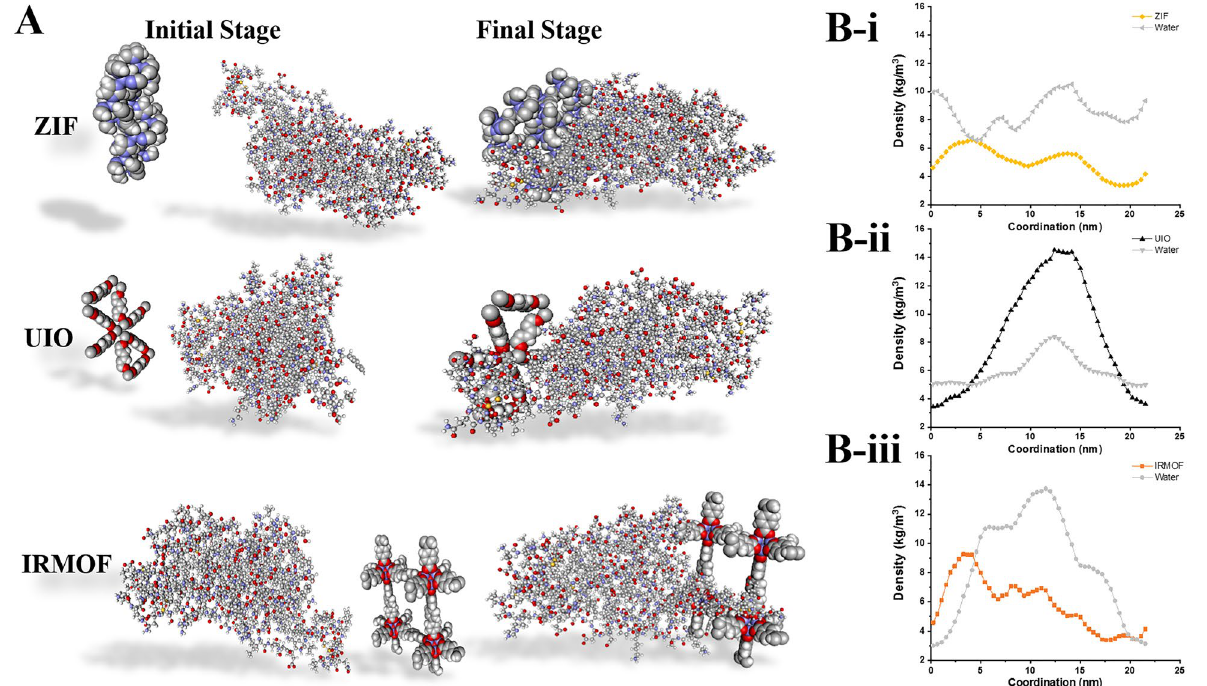
Figure 2. ( A ) Snapshots of the initial and final stages of the interactions between MOF structures with S protein. Water molecules as background are ignored. ( B-i – iii ) density distribution of MOF structures and water along with the simulation boxes for ZIF, UIO, and IRMOFs,